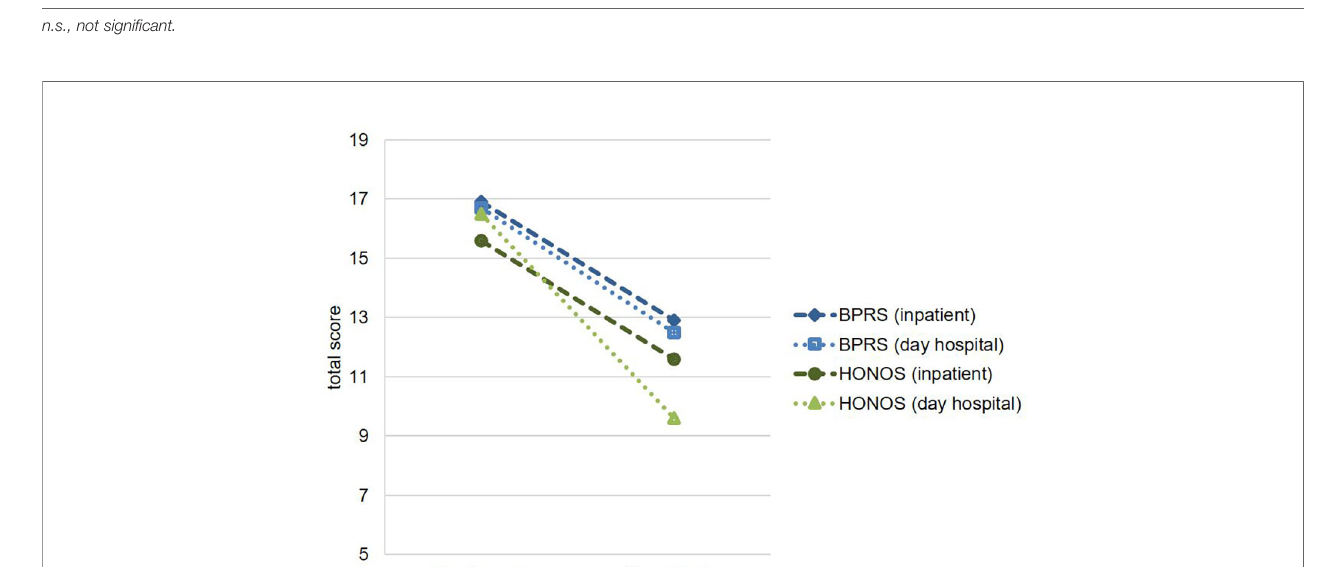
FIGURE 2 | Change in psychopathology under treatment. BPRS, Brief Psychiatric Rating Scale; HoNOS, Health of the Nation Outcome Scales (means of total scores).